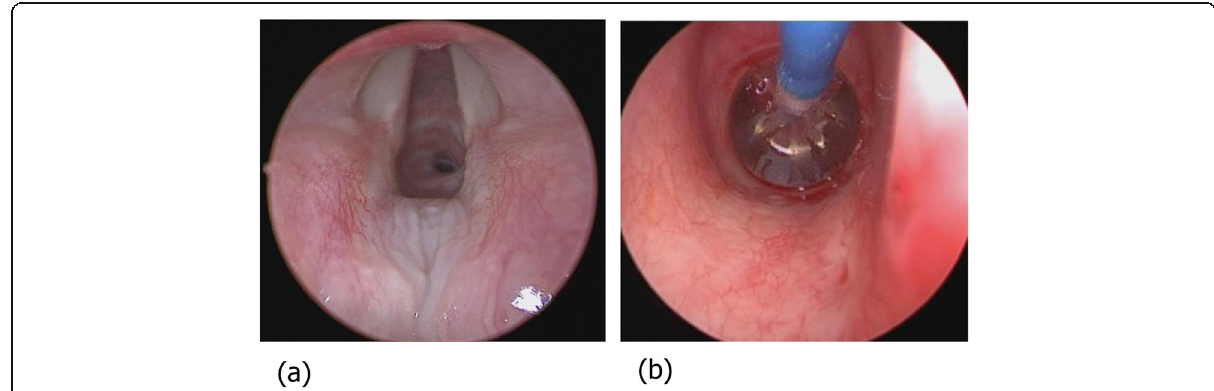
Fig. 2 Endoscopic photographs of airway